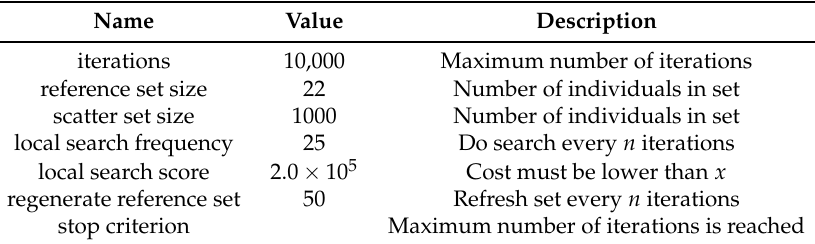
Table 1. Parameter settings for sequential scatter